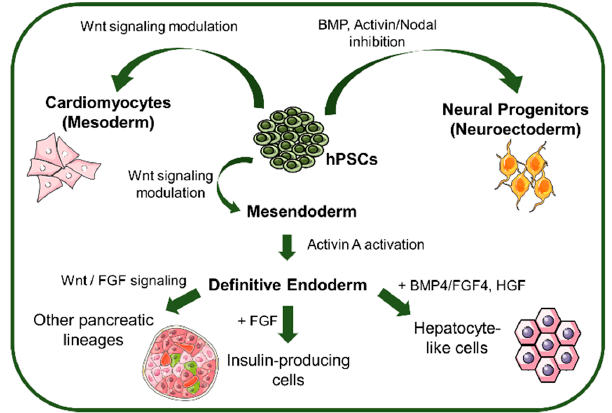
Figure 3. Signaling pathways and morphogens that control lineage specification from hPSCs. hPSCs can be differentiated towards the different lineages by BMP and Activin/Nodal inhibition (Neuroectoderm), Wnt signaling modulation (mesoderm and mesendoderm), and further differentiated to definitive endoderm by Activin A activation to generate pancreatic and hepatic lineage-derived cells. BMP: bone morphogenic protein, FGF: fibroblast growth factor, HGF: hepatoblast growth factor.